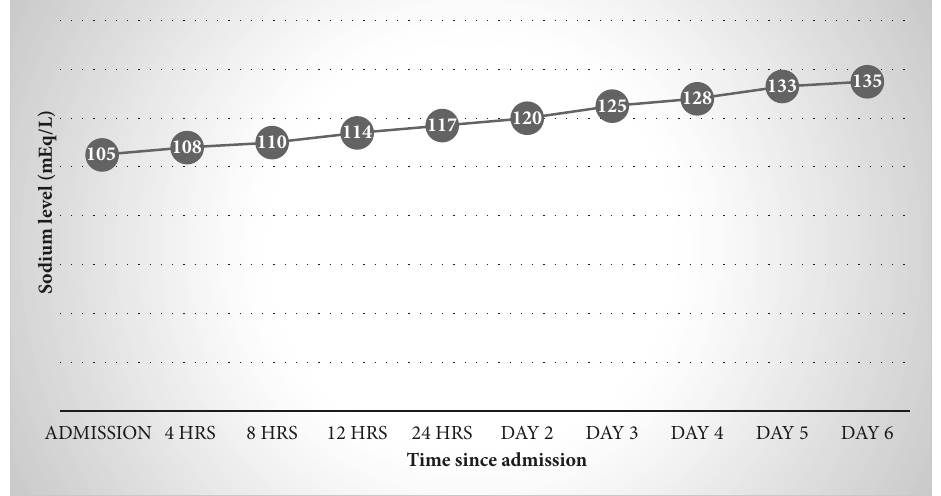
Figure 1: Sodium levels of the patient during the course of